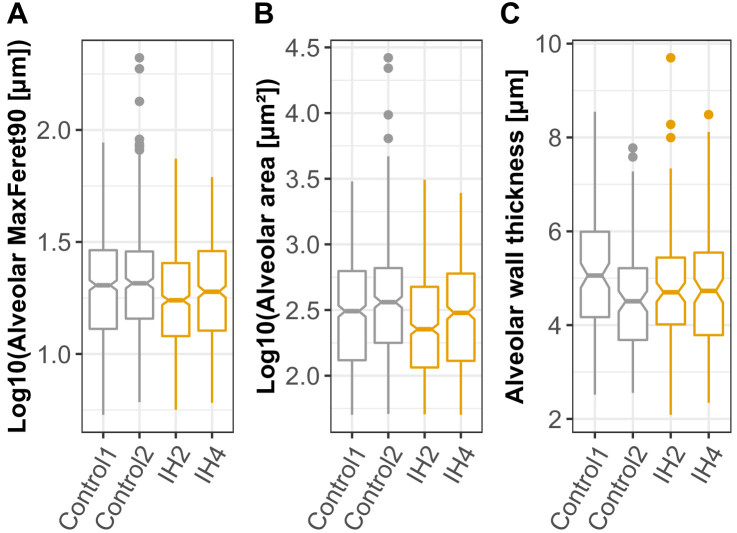
Alveolar area and alveolar wall thickness are quantified from confocal images for mice exposed to IH compared to controls.MaxFeret90 (A) and alveolar areas (B) are quantified in Nikon Elements. Maxferet90 is the distance measured orthogonally to the maximum feret chord. The higher Maxferet90 value indicates larger space in the alveolus. N = 2 mice for controls and IH-exposed mice, with three images per mouse. Autofluorescence with the TRITC channel was used to define alveolar areas. (C) Alveolar wall thickness was quantified in Imaris, using the measurement tool for autofluorescence to define the alveolar walls. A total of 20 alveolar wall thickness measurements were taken for each 60× magnification confocal image (n = 2 mice per treatment, six images per mouse).